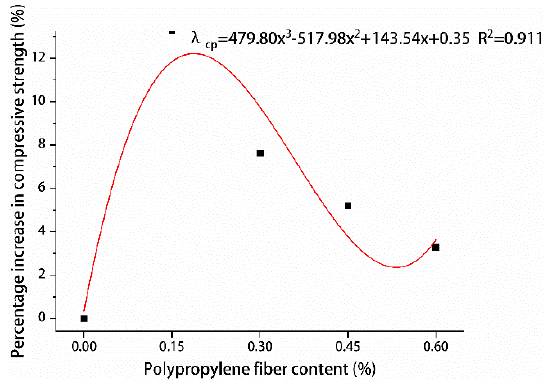
Figure 22. Relationship between compressive strength and polypropylene fiber content.